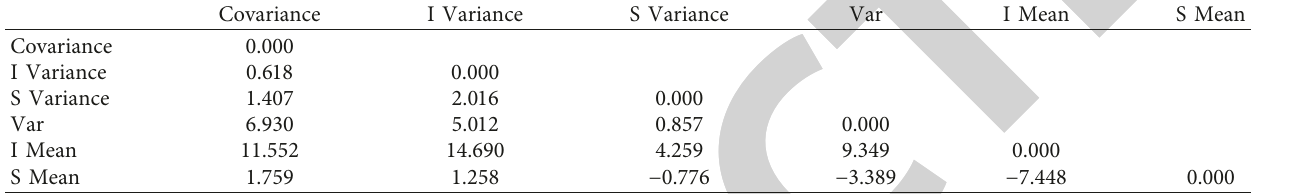
Table 10: Critical ratios for differences between parameters.